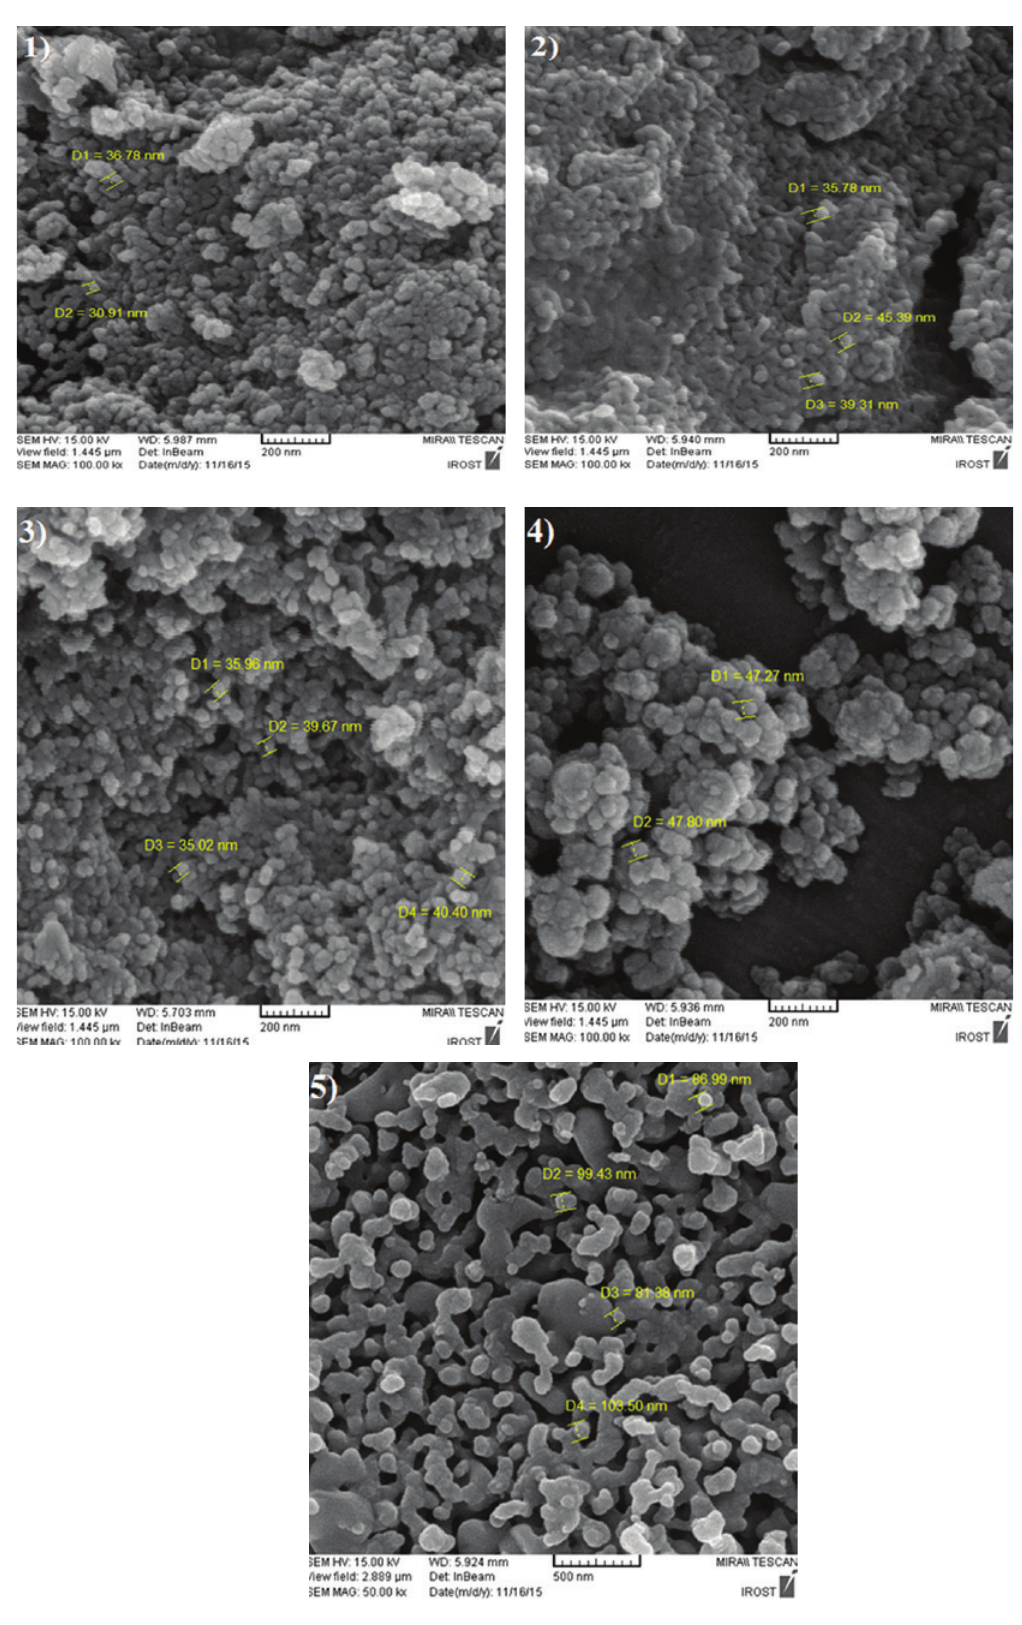
Figure 2: FE-SEM images of samples before immersion in SBF. (1) HA, (2) CA, (3) nanocomposite obtained by method 1, (4) nanocomposite obtained by method 2, and (5) nanocomposite obtained by method